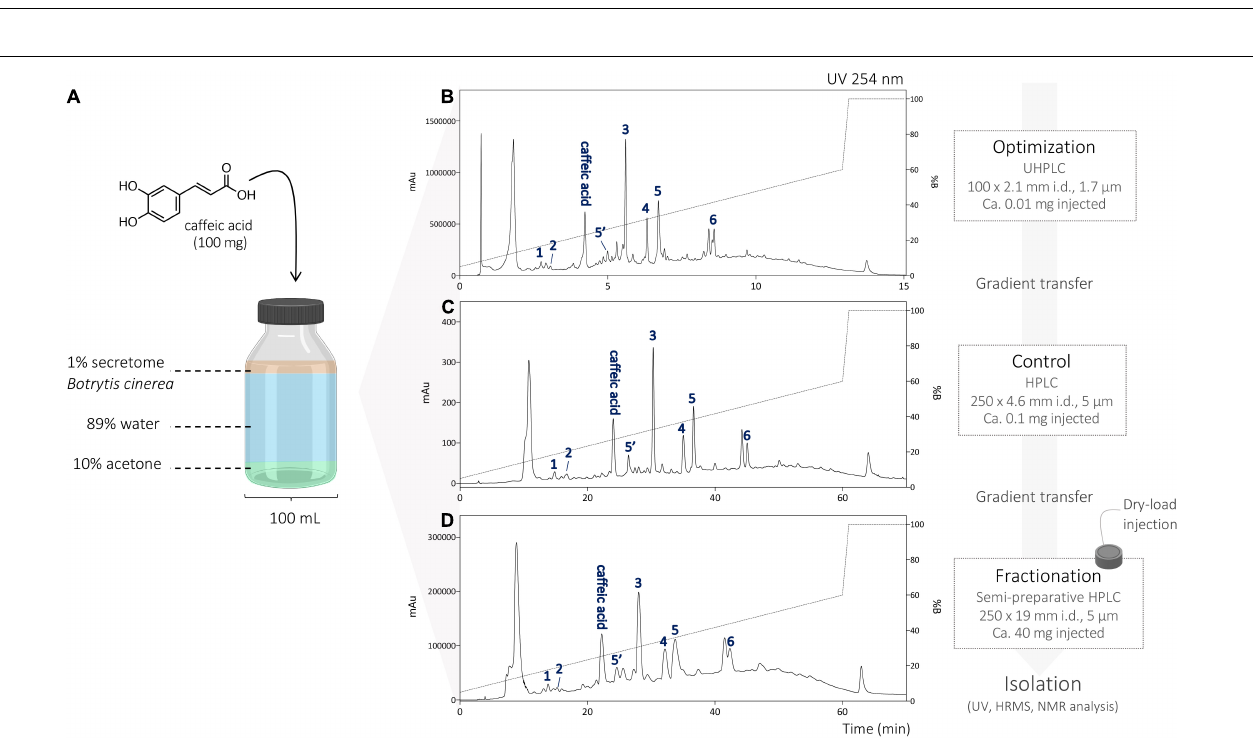
FIGURE 3 | (A) Scaled up biotransformation reaction of caffeic acid with the enzymatic secretome of B. cinerea and 10% of acetone. (B) UHPLC-PDA analysis with optimized chromatographic conditions. (C) HPLC-PDA analysis using the transferred optimized chromatographic conditions. (D) Semi-preparative HPLC-UV analysis using the transferred optimized chromatographic conditions, and isolation of the generated compounds.